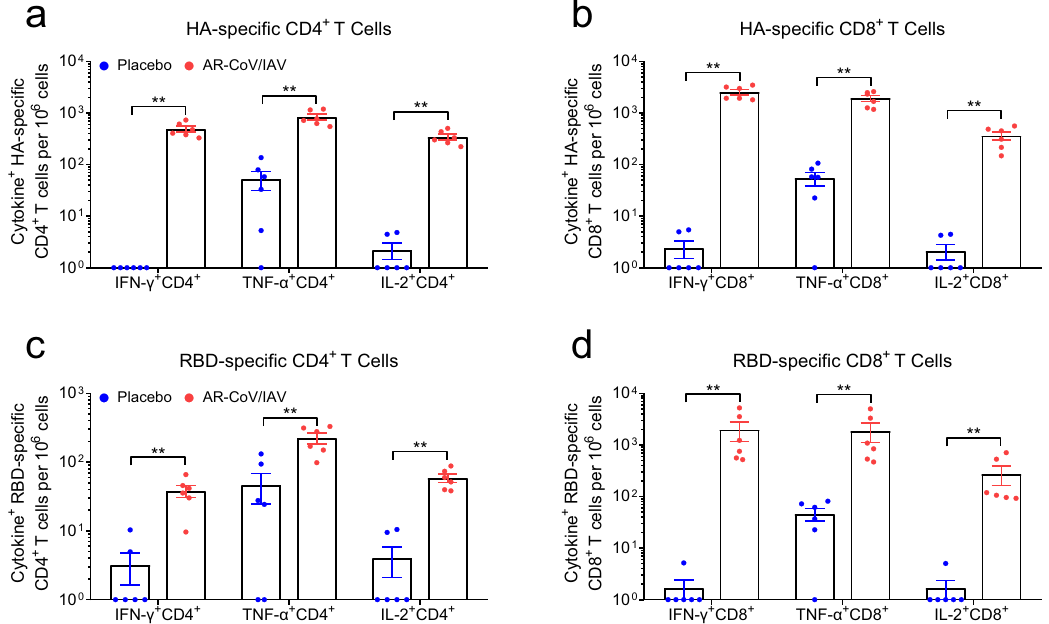
Fig. 3 AR-CoV/IAV immunization elicits an antigen-speci fi c T cell immune response in BALB/c mice. a , b HA-speci fi c CD4 + and CD8 + T cells producing IFN- γ , TNF- α and IL-2 were determined by fl ow cytometry. c , d RBD-speci fi c CD4 + and CD8 + T cells producing IFN- γ , TNF- α and IL-2 were determined by fl ow cytometry. Data are shown as the mean ± SEM ( n = 6). Statistical differences were analyzed by using unpaired t tests. ** P <